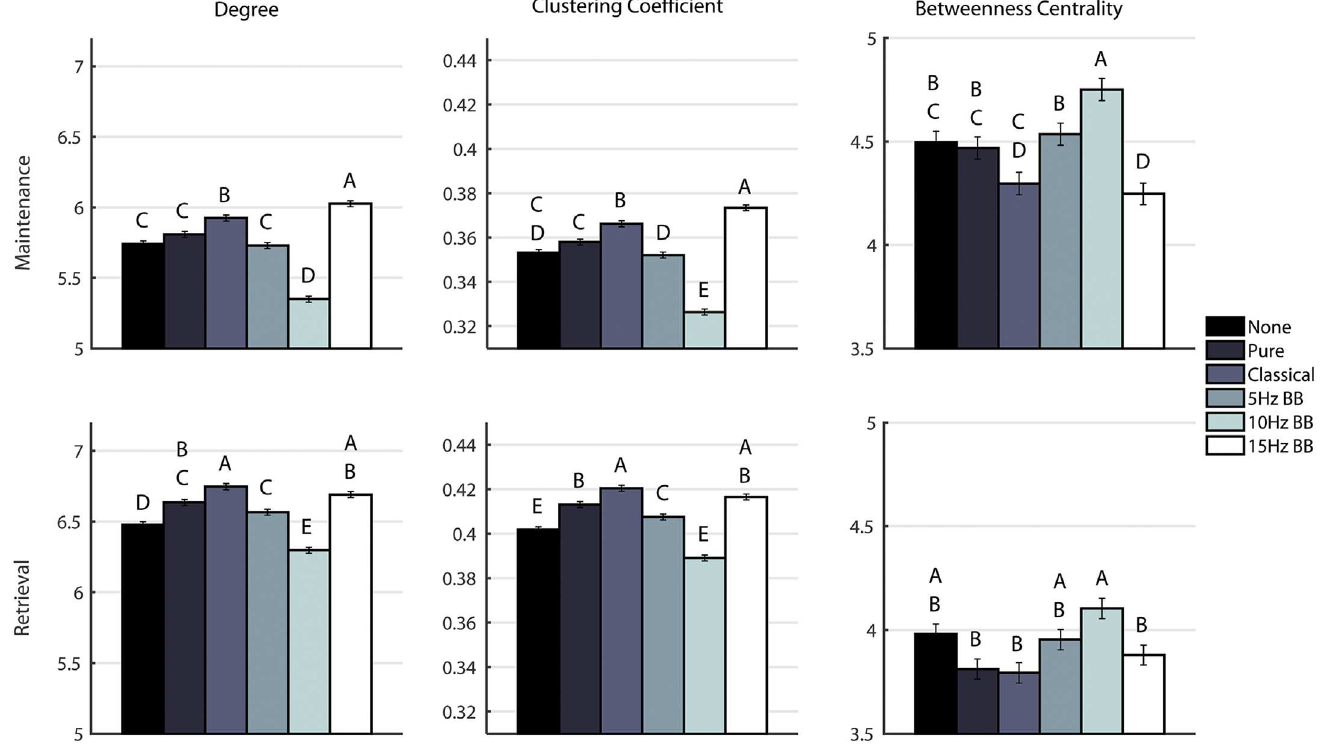
Fig 9. Comparison of degree, clustering coefficient, and betweenesscentrality for each condition. Conditions marked with different letters are significantly different. The bars show